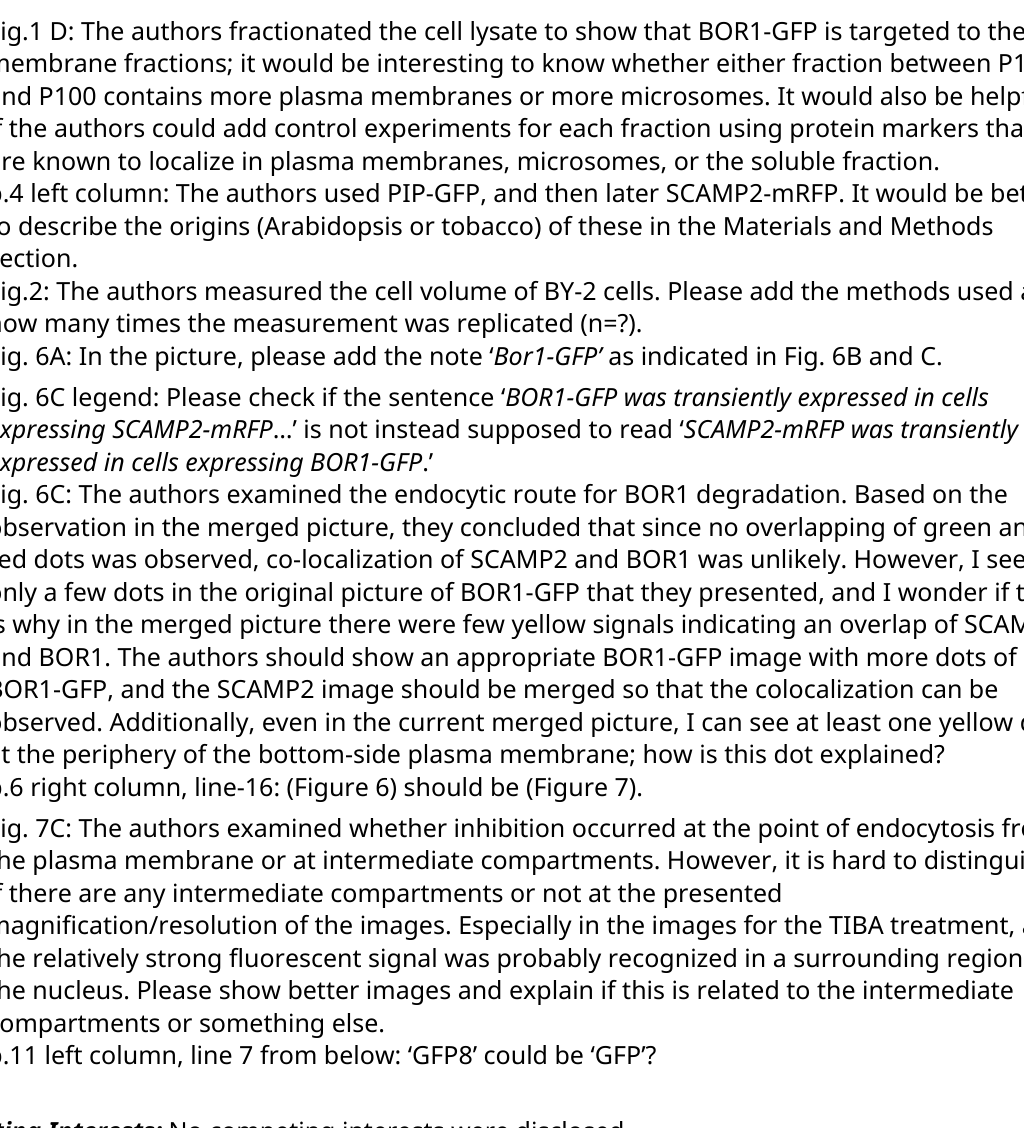
Fig.1 D: The authors fractionated the cell lysate to show that BOR1-GFP is targeted to the